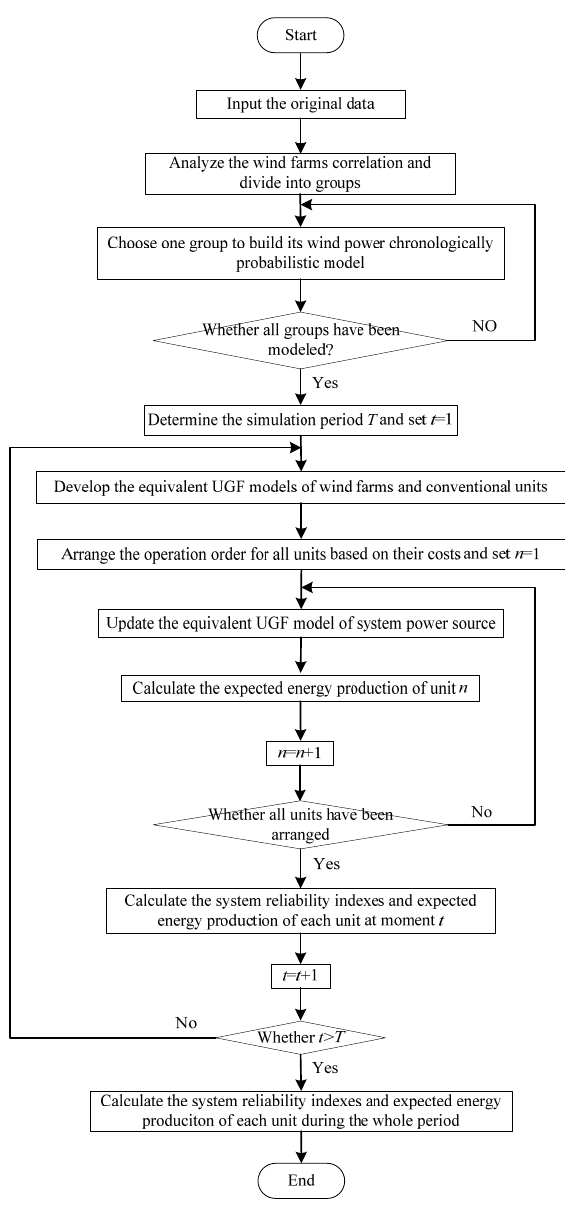
Figure 2. Flowchart of the proposed probabilistic production simulation (PPS) method based on universal generating function (UGF).